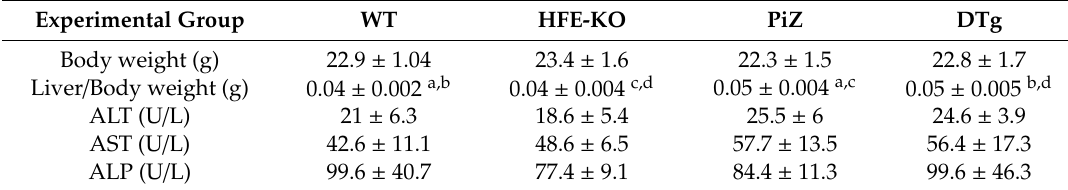
Table 2. Liver values, serum parameters, and body weights in three months old mice. Experimental Group WT HFE-KO